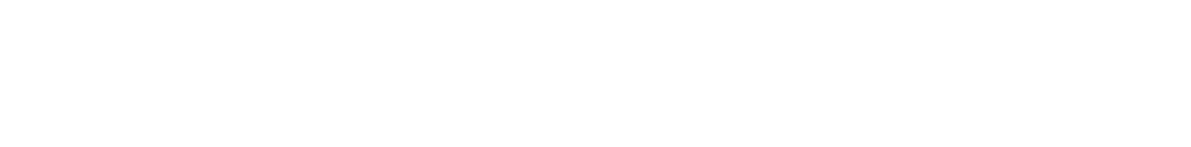
Frontiers in Built Environment |